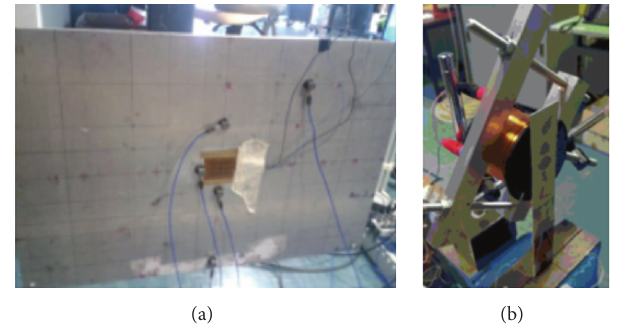
Figure 10: Experimental set-ups: plate (a) and beam (b).